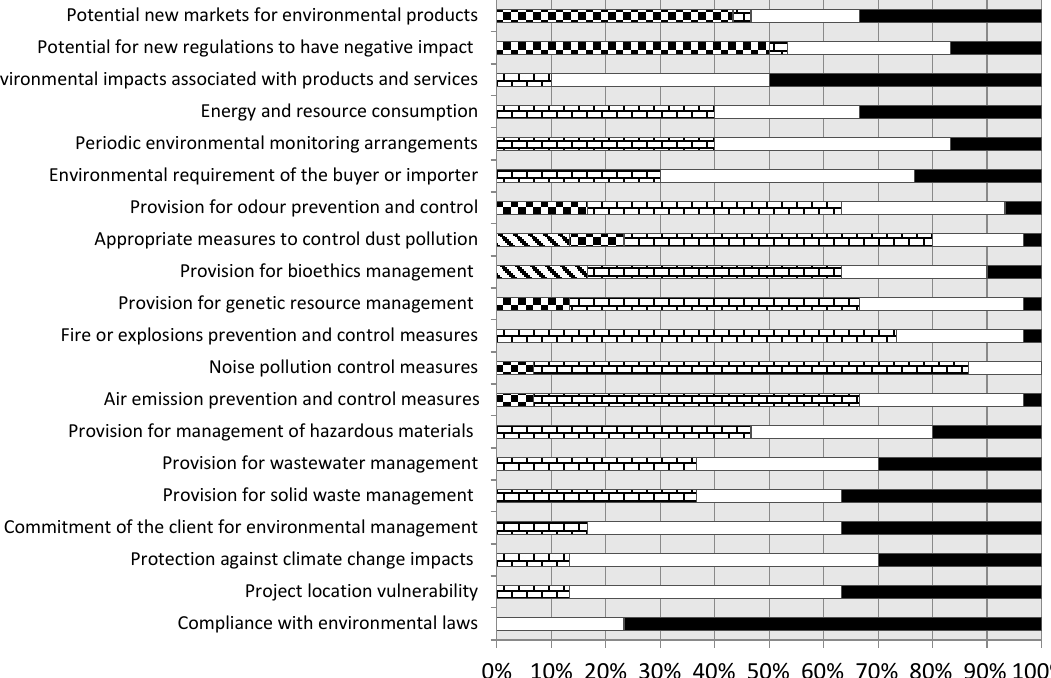
Figure 1. Environmental issues considered in lending (respondents were allowed to pick multiple